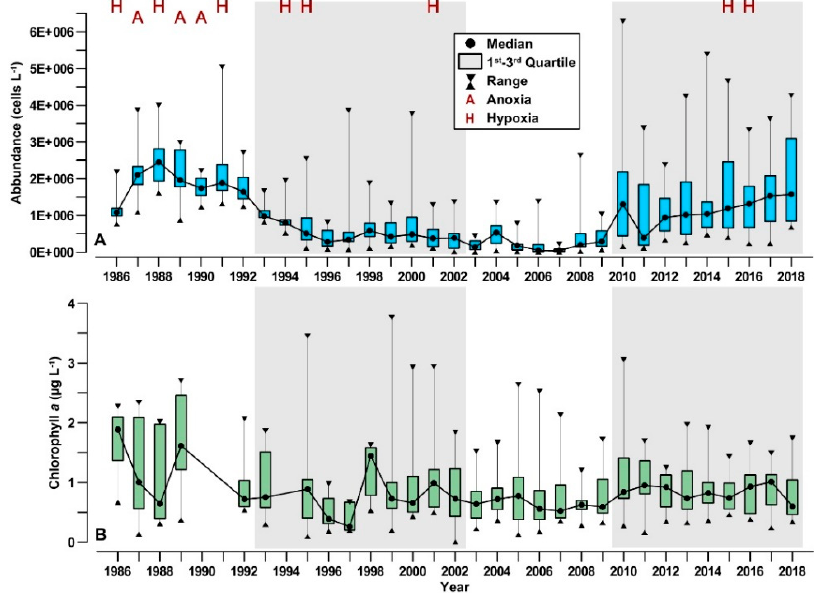
Figure 2. Annual medians, quartiles and ranges of depth-integrated data of ( A ) phytoplankton abundance (cells L − 1 ) and ( B ) chlorophyll a concentration (µg L − 1 ) at the station C1, in 1986–2018. The largest events of hypoxia and anoxia observed in the Gulf of Trieste (GoT) are also shown. Alternated white–gray areas indicate the major phases characterizing the evolution of phytoplankton community: eutrophic (1986–1992), posteutrophic (1993–2002), oligotrophic (2003–2009) and unstable